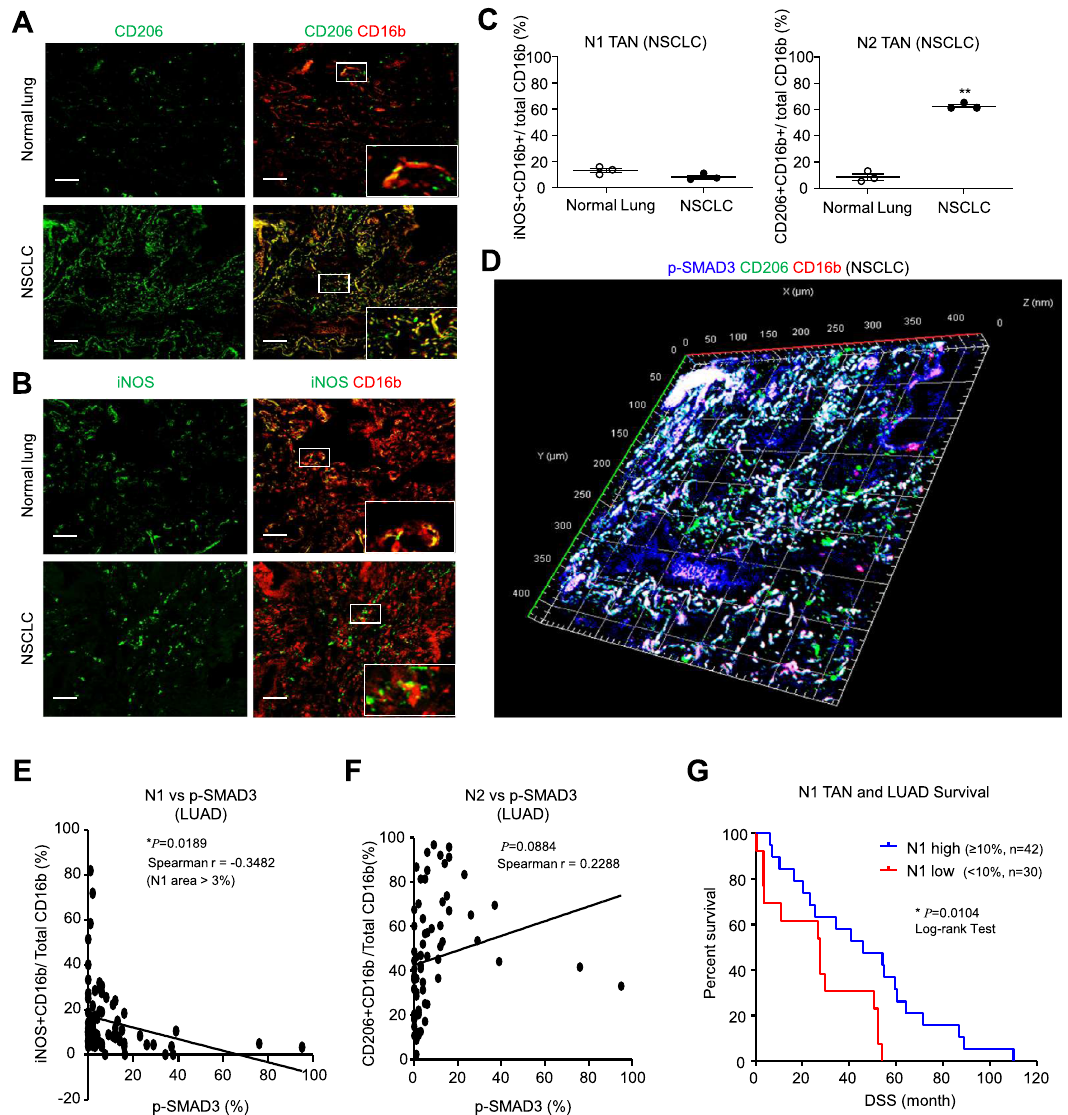
Fig. 1 | SMAD3 activation is negatively associated with an N1 phenotype in NSCLC. A – C Confocal imaging and quanti fi cation show a marked accumulation of N2TANs(CD206 + CD16b + cells)inNSCLCcomparedtoadjacentnormallungtissue, which contrasts with the small population of N1 TANs (iNOS + CD16b + cells) (** P <0.01 vs. normal lung; two-tailed t -test). D Three-dimensional confocal image showingSMAD3activation(p-SMAD3,blue)inmanyN2TANs(CD206 + CD16b + cells) in NSCLC. Correlation analysis shows that Smad3 activation ( E ) has a negative